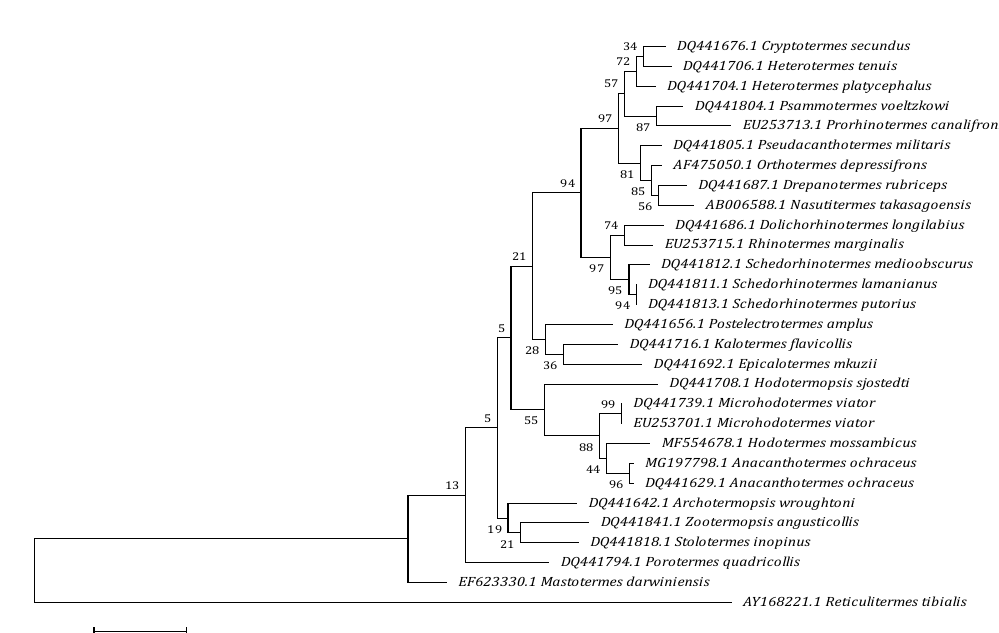
Figure. 1 Sequence alignment of the 12S rRNA of A. ochraceus with the most related species (Only variable sites are shown. Dots represent the bases identical to those of the first sequences, and dashes indicate gaps).